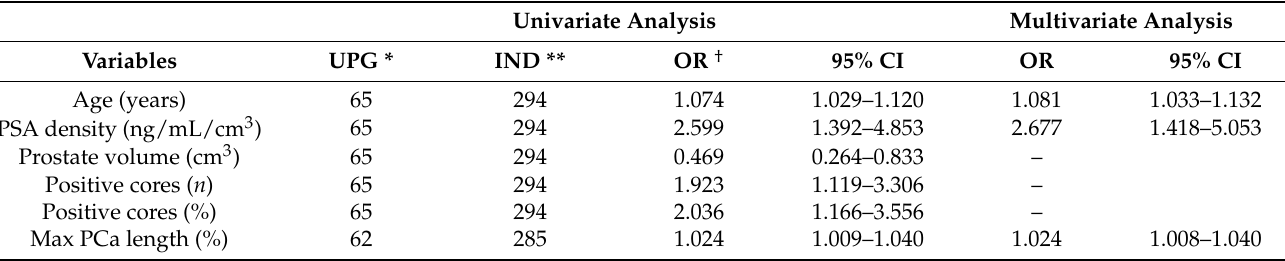
Table 3. Results from the univariate and multivariate logistic models on the overall cohort (clinico-pathological variables). Univariate Analysis Multivariate